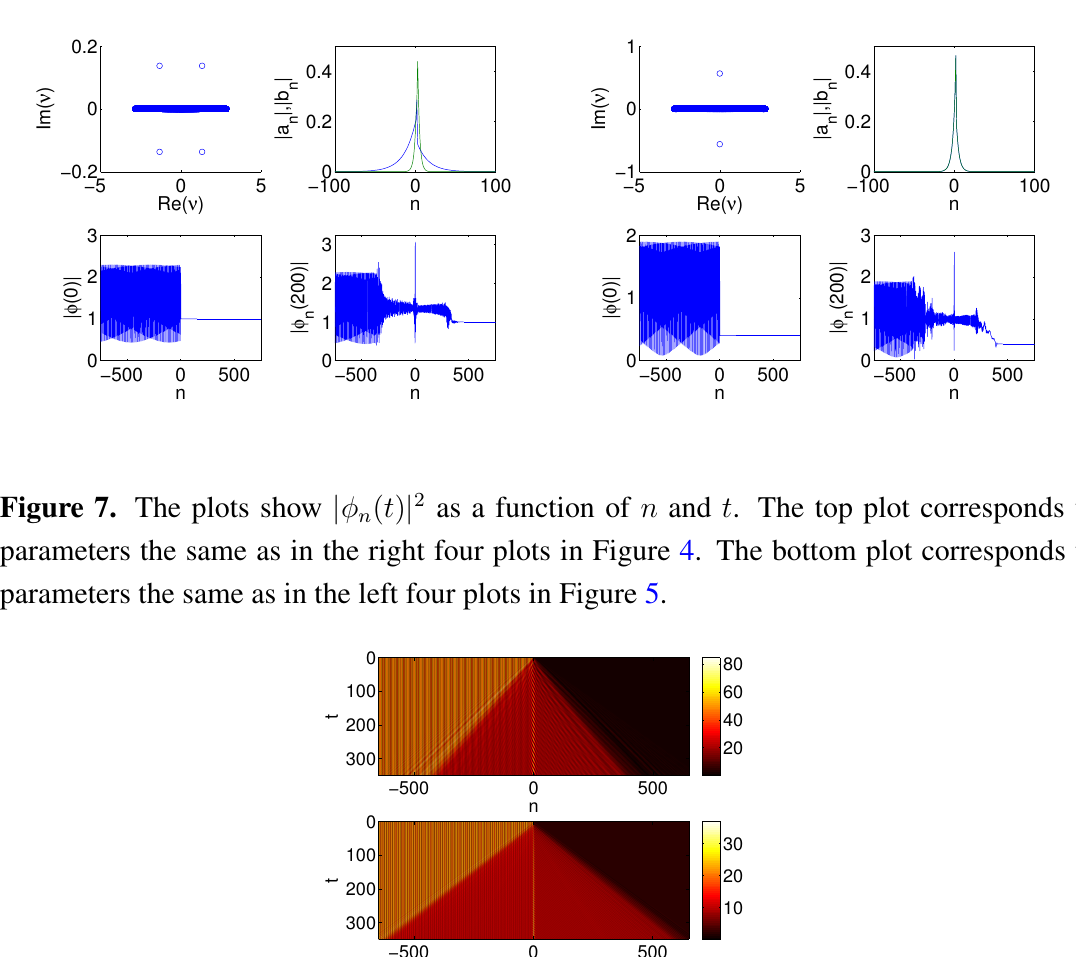
these two sets of four plots shows the transition in the eigenvalue plots as we move towards brighter regions of the appropriate | min( Im ( ν )) | diagram in Figure 3.